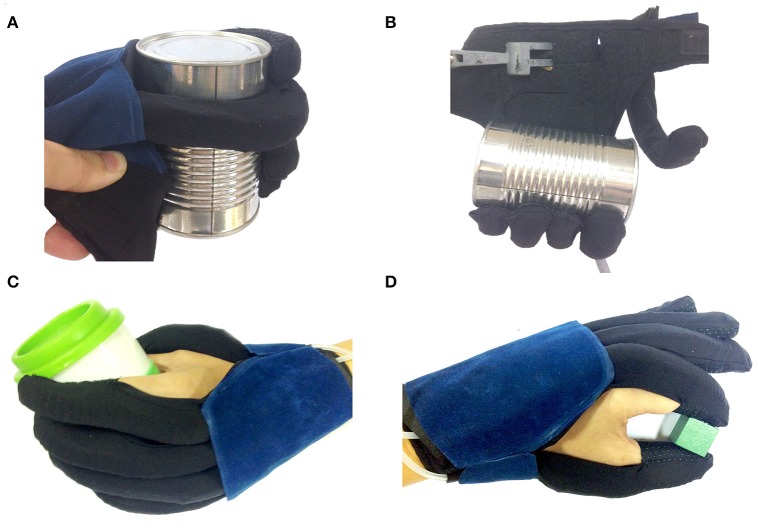
The glove generated sufficient force to lift a 454 g-weighted can in the (A) vertical and (B) horizontal orientation. (C) Palmar grasp, (D) Pincer grasp achieved with the assistance of the glove.